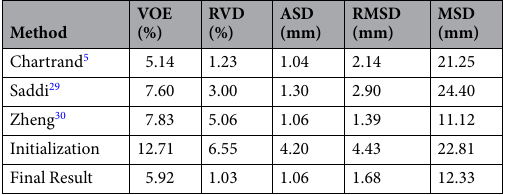
Table 1. The quantitative comparative results for the Sliver07 dataset as mean.